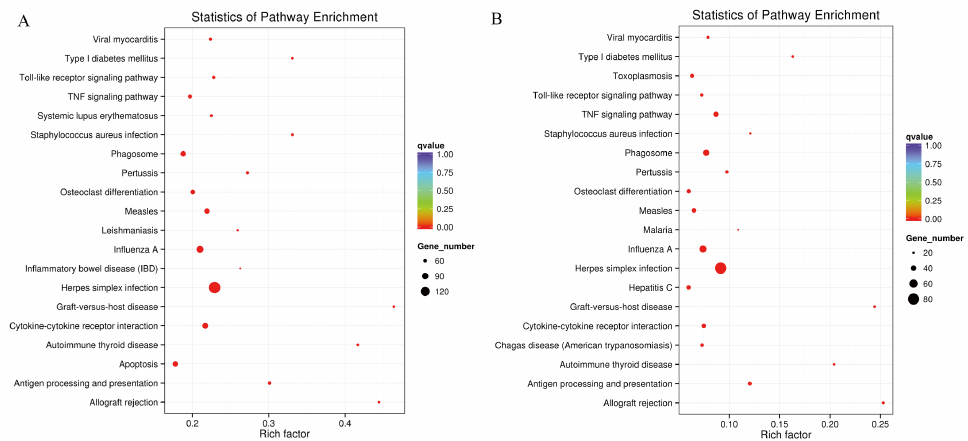
Figure 4. The top 20 enriched KEGG pathways in the EV71-infected group ( A ) and CVA16-treated group ( B